Question: Describe this figure in one sentence.
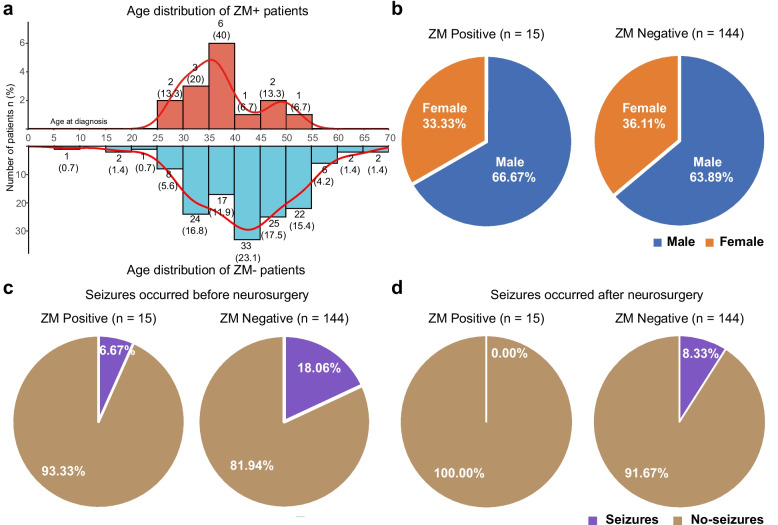
Answer: Clinical characteristics associated with ZM fusion status in sGBM. a Age distribution of ZM-positive and ZM-negative patients. ZM-positive patients were mainly concentrated in younger to middle-adult age groups, whereas ZM-negative patients showed a broader age range. b Sex distribution of ZM-positive and ZM-negative patients. c Preoperative seizure occurrence in ZM-positive and ZM-negative groups. Seizures were less frequently observed in ZM-positive patients before neurosurgery. d Postoperative seizure occurrence in ZM-positive and ZM-negative groups. No postoperative seizures were observed in the ZM-positive cohort, whereas a small proportion of ZM-negative patients experienced postoperative seizures